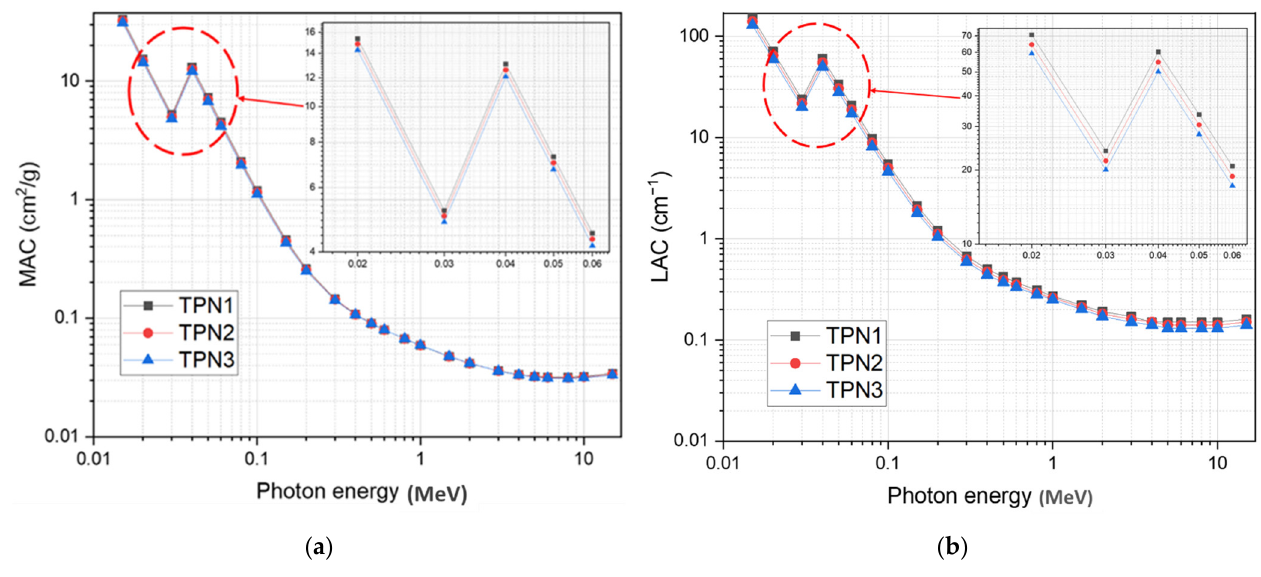
Figure 4. ( a ) The mass attenuation coefficient of prepared glasses; ( b ) The linear attenuation coefficient of prepared glasses. Table 4. The calculated mass attenuation coefficient (MAC) and linear attenuation coefficient (LAC) values for TPN glass